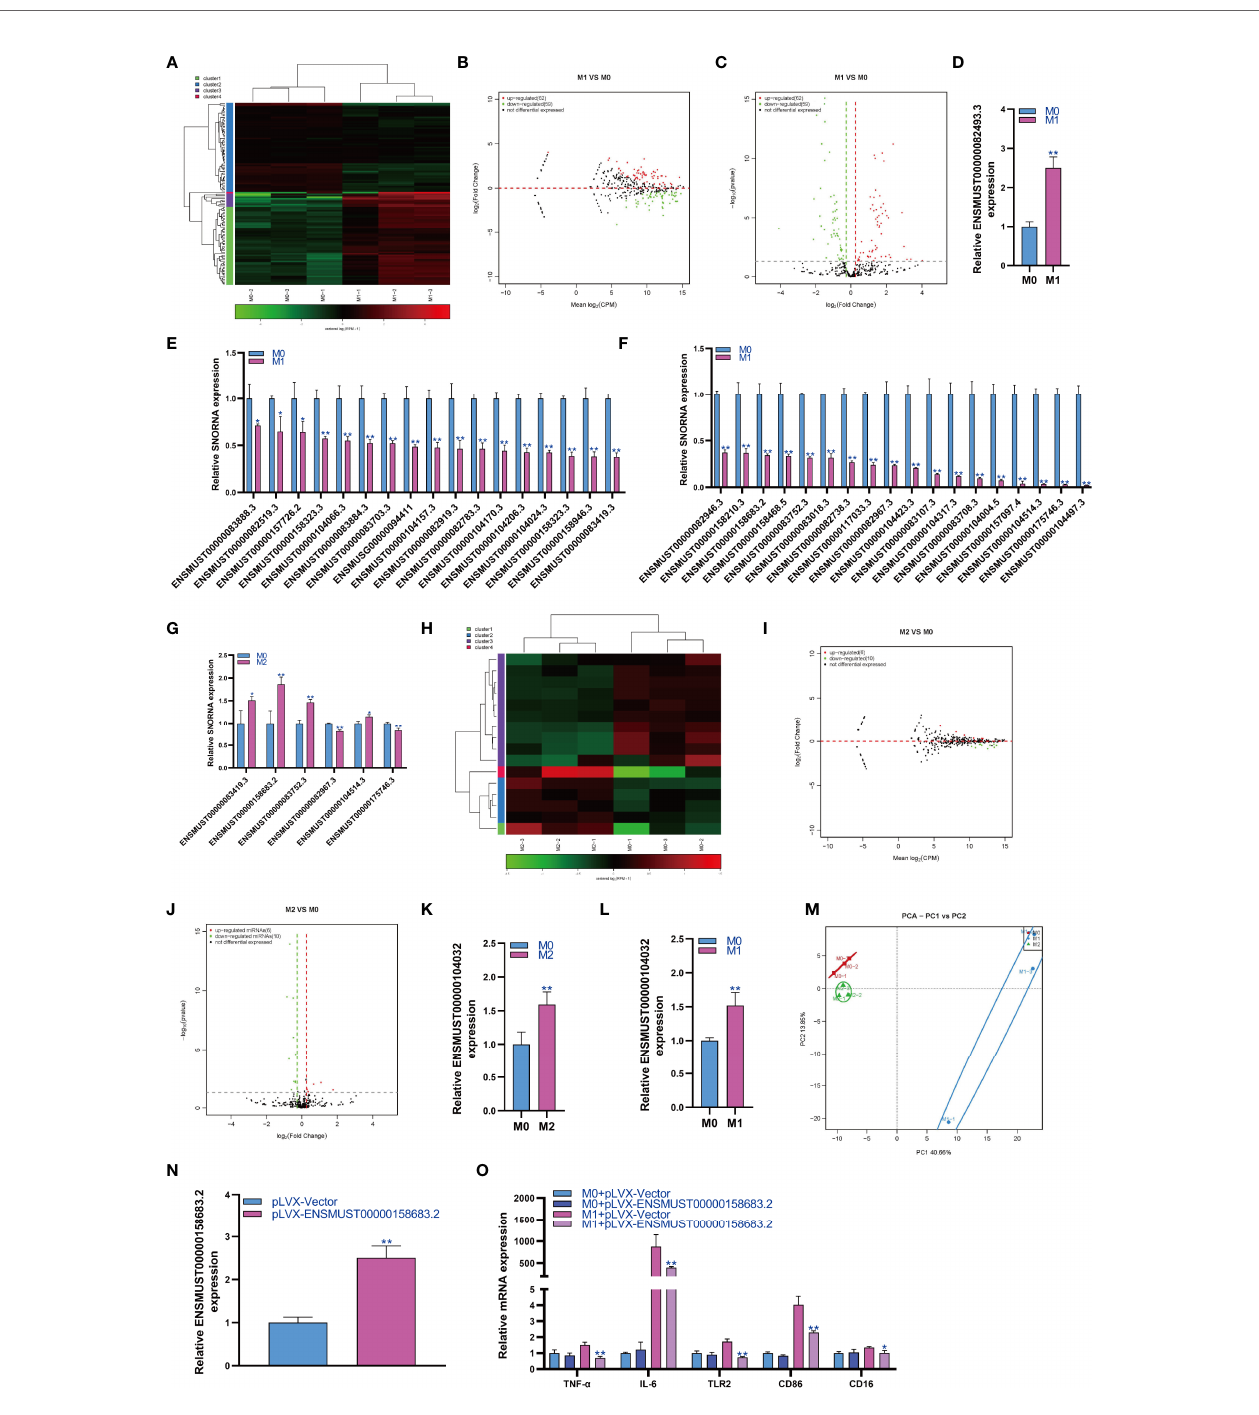
FIGURE 3 | Changes in snoRNA expression during macrophage polarization. Hotmap (A) , MA (B) and volcano plot (C) show the small RNA sequencing results of the expression of snoRNA in M0 and M1 macrophages. (D) The expression of snoRNA upregulated in M1 macrophages as detected by qPCR. (E, F) The expression of snoRNA was downregulated in M1 macrophages as detected by qPCR. (G) The expression of snoRNA in M2 macrophages as detected by qPCR. Hotmap (H) , MA (I) and volcano plot (J) show the small RNA sequencing results of the expression of snoRNA in M0 and M2 macrophages. (K) The expression of snoRNA in M2 macrophages as detected by qPCR. (L) The expression of piRNA in M1 macrophages as detected by qPCR. (M) PCA of snoRNA expression in M0, M1 and M2 macrophages. * indicates p < 0.05 compared to M0, and ** indicates p < 0.01 compared to M0. (N) The expression of snoRNA ENSMUST0000 0158683.2 in RAW264.7 cells transfected with pLVX-Vector or pLVX-ENSMUST00000158683.2 were detected by qPCR. (O) The expression of TNF- a , IL-6, TLR2, CD86 and CD16 in RAW264.7 cells were detected by qPCR, * indicates p < 0.05 and ** indicates p < 0.01 compared to M1+ pLVX-Vector